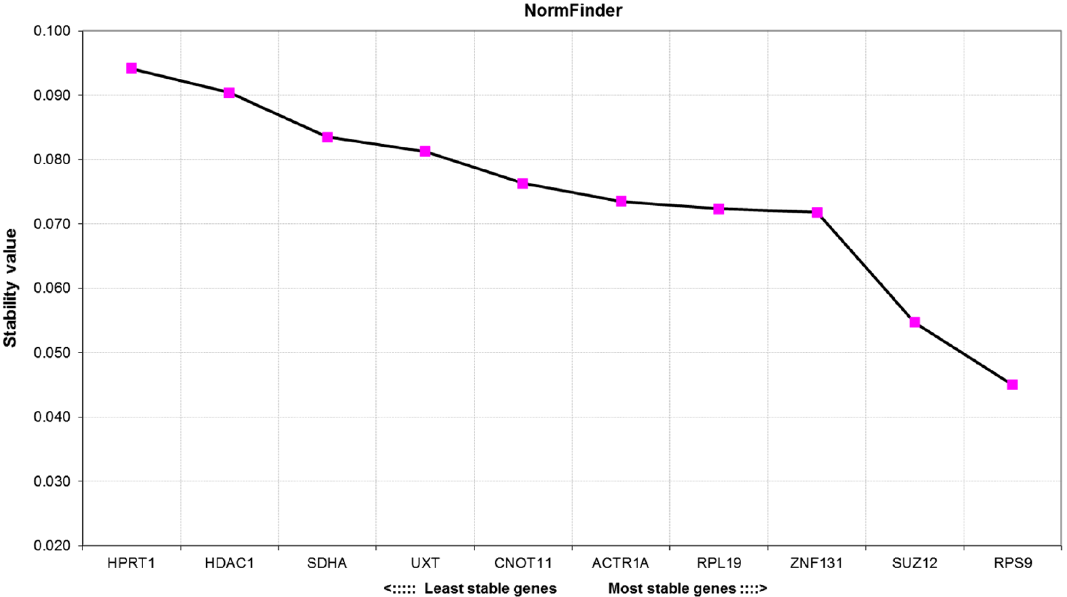
Figure 2. Stability value (SV) of candidate reference genes calculated by the NormFinder algorithm. The lower the SV, the more stably is the gene expressed in the tested samples.